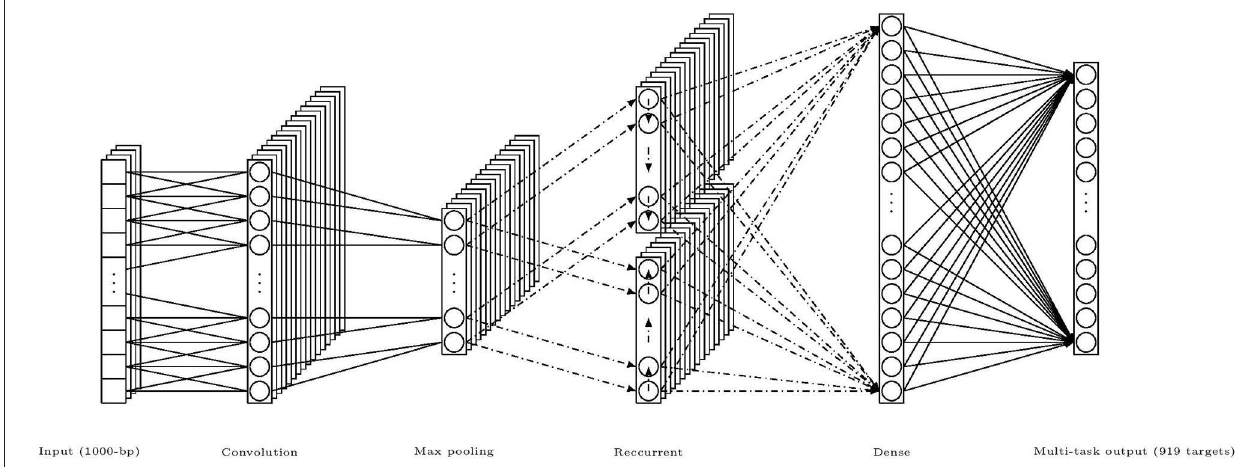
FIGURE 3 | An illustration of the hybrid framework of DanQ model, (channels and nodes shown in the figure are not of exact number used in the model, but for illustrative purpose; dash-dot arrows mean that there are